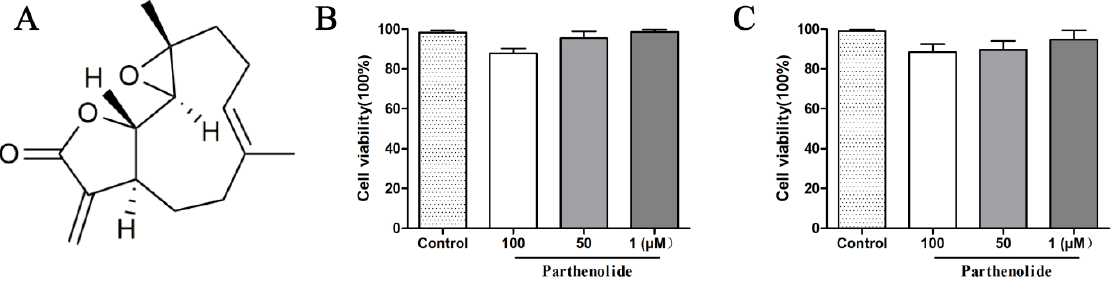
Figure 7. ( A ) Chemical structure of PTL. ( B ) Inhibition of Caco-2 cells’ and HepG2 cells’ viability by PTL at 100, 50, 1 μ M. The experiments were performed in triplicate and are expressed as mean ±